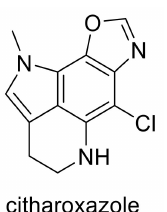
Figure 20. Structure of citharoxazole, a lead-like compound isolated from the deep-sea Mediterranean sponge, Latrunculia (Biannulata) citharistae [45].